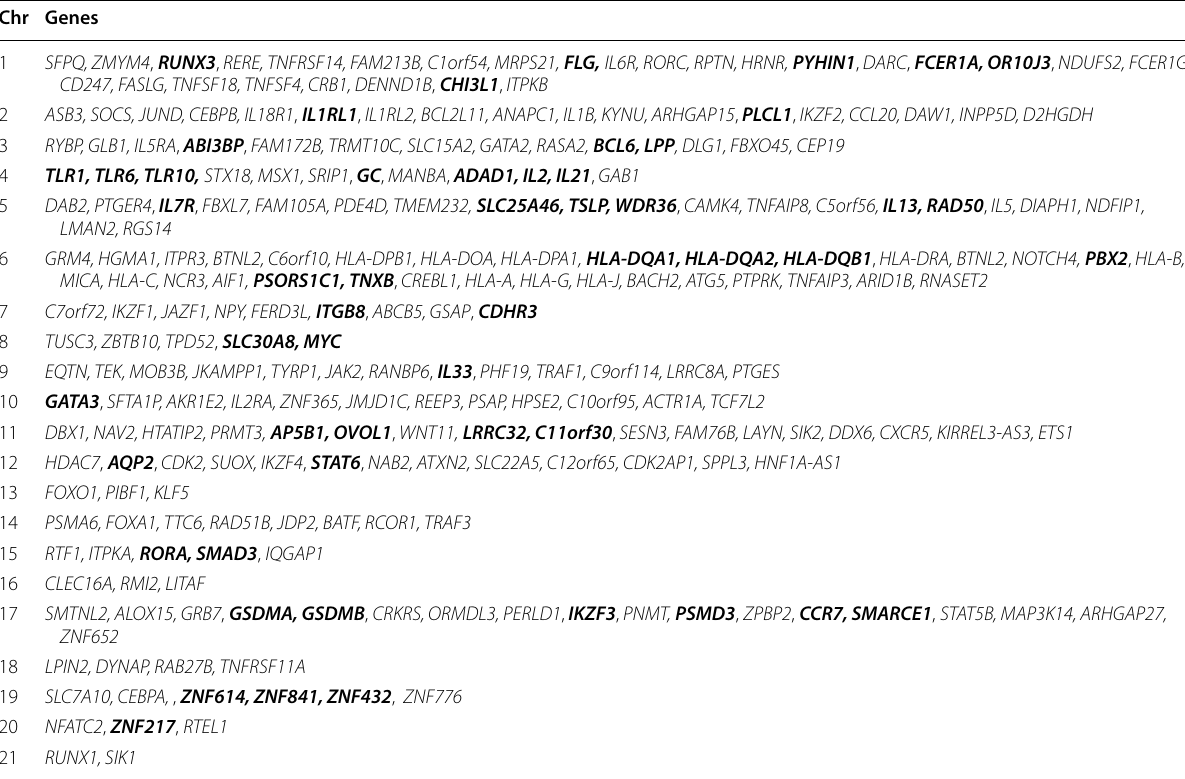
Table 1 The list of all reported genes associating with asthma/AR/CRS GWAS SNPs at the level of P < 10 exp ‑8. The reviewed genes are shown in bold Chr